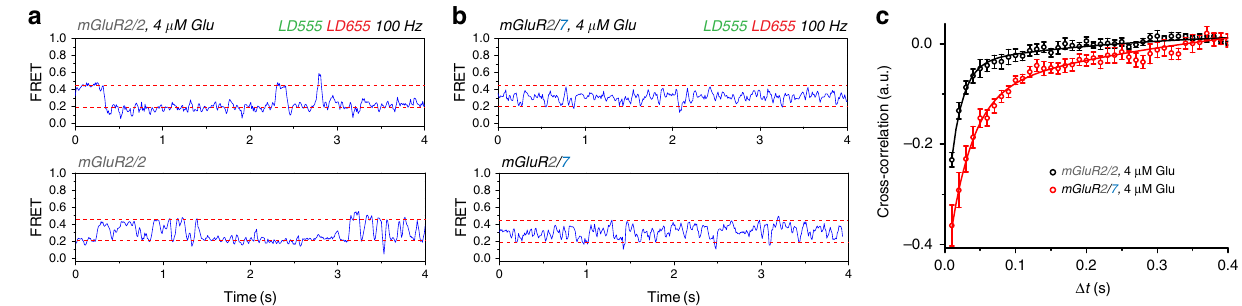
Fig. 7 Fast glutamate-induced conformational dynamics in mGluR2/7. SNAP-mGluR2/SNAP-mGluR2 (mGluR2/2) and CLIP-mGluR2/SNAP- mGluR7 (m,GluR2/7) at a glutamate concentration near the EC50 (4 µ M) imaged at 10× speed (100 Hz) with photobleaching resistant dyes (donor BC-LD555 or BG-LD555 and acceptor BG-LD655). a , b mGluR2/2 and mGluR2/7 transition between resting (high FRET) and activated (low FRET), but CLIP-mGluR2/SNAP-mGluR7 spends much of the time at an intermediate FRET level. c Donor/acceptor cross-correlation decays over longer time in mGluR2/7. Both samples fi t with double exponential decay, mGluR2/2 R 2 = 0.9120 (8 movies, 396 molecules, s.e.m. error bars) and mGluR2/7 R 2 = 0.9740 (8 movies, 384 molecules, s.e.m.